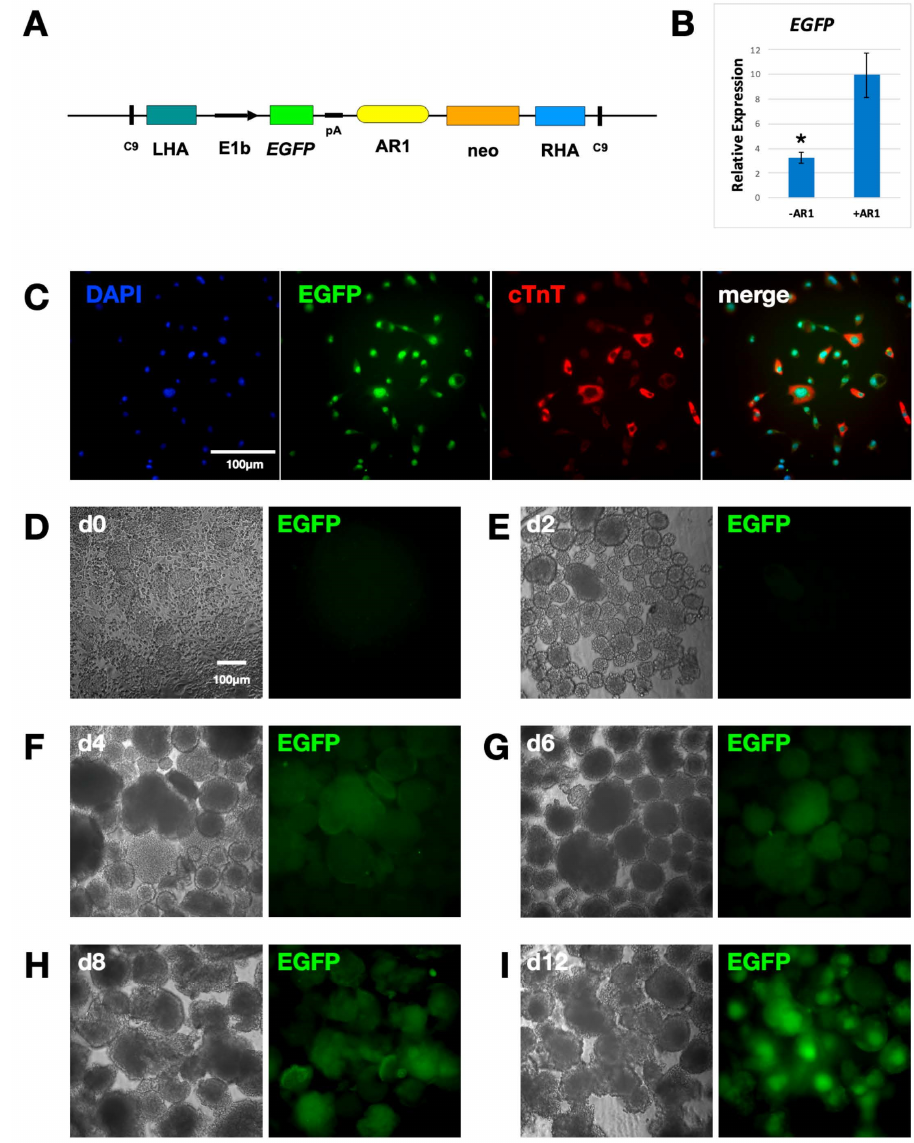
Figure 2. The AR1 cardiac enhancer in Hipp11 activates expression of EGFP in differentiating cells. ( A ) Schematic of the AR1 ‐ EGFP plasmid. It contains the neomycin resistance cassette (neo) and the EGFP gene under the control of the minimal promoter E1b and AR1 enhancer, flanked by the LHA, RHA and two CRISPR/Cas9 target sites (C9). ( B ) Real ‐ time RT ‐ PCR analysis showing relative ex ‐ pression of EGFP in the Hipp11 locus of differentiated cells, in the absence and presence of AR1 (n = 3, * p < 0.05). Primers are listed in the Supplementary Material (Table S3). ( C ) Immunofluorescence of AR1 ‐ EGFP mES cells, differentiated into cardiomyocytes. Cells expressing cardiac troponin T (cTnT) also upregulate EGFP. ( D ) Colonies of undifferentiated AR1 ‐ EGFP mESC showing no fluo ‐ rescence. Magnification 10×. ( E – I ) AR1 ‐ EGFP embryoid bodies (EB), on days 2, 4, 6, 8 and 12, show ‐ ing upregulation of EGFP, starting from day 4 of EB formation. On day 8, EGFP ‐ expressing cardiac cells start migrating into the centre of the EB. Magnification 10×. 2.2.2. AR1 Upregulates Flp Expression in Differentiating Cardiac Cells EGFP is not an overly sensitive read ‐ out of AR1 activity. It is conceivable that AR1 in mESC may not be active enough to provide a detectable fluorescent signal but can pro ‐ duce amounts of dtA capable of killing the cells. Enzyme function is much more likely to be affected by enhancer activation, as a few molecules are typically sufficient to catalyze a reaction. For this reason, and in order to confirm the suitability of AR1 for our purposes,